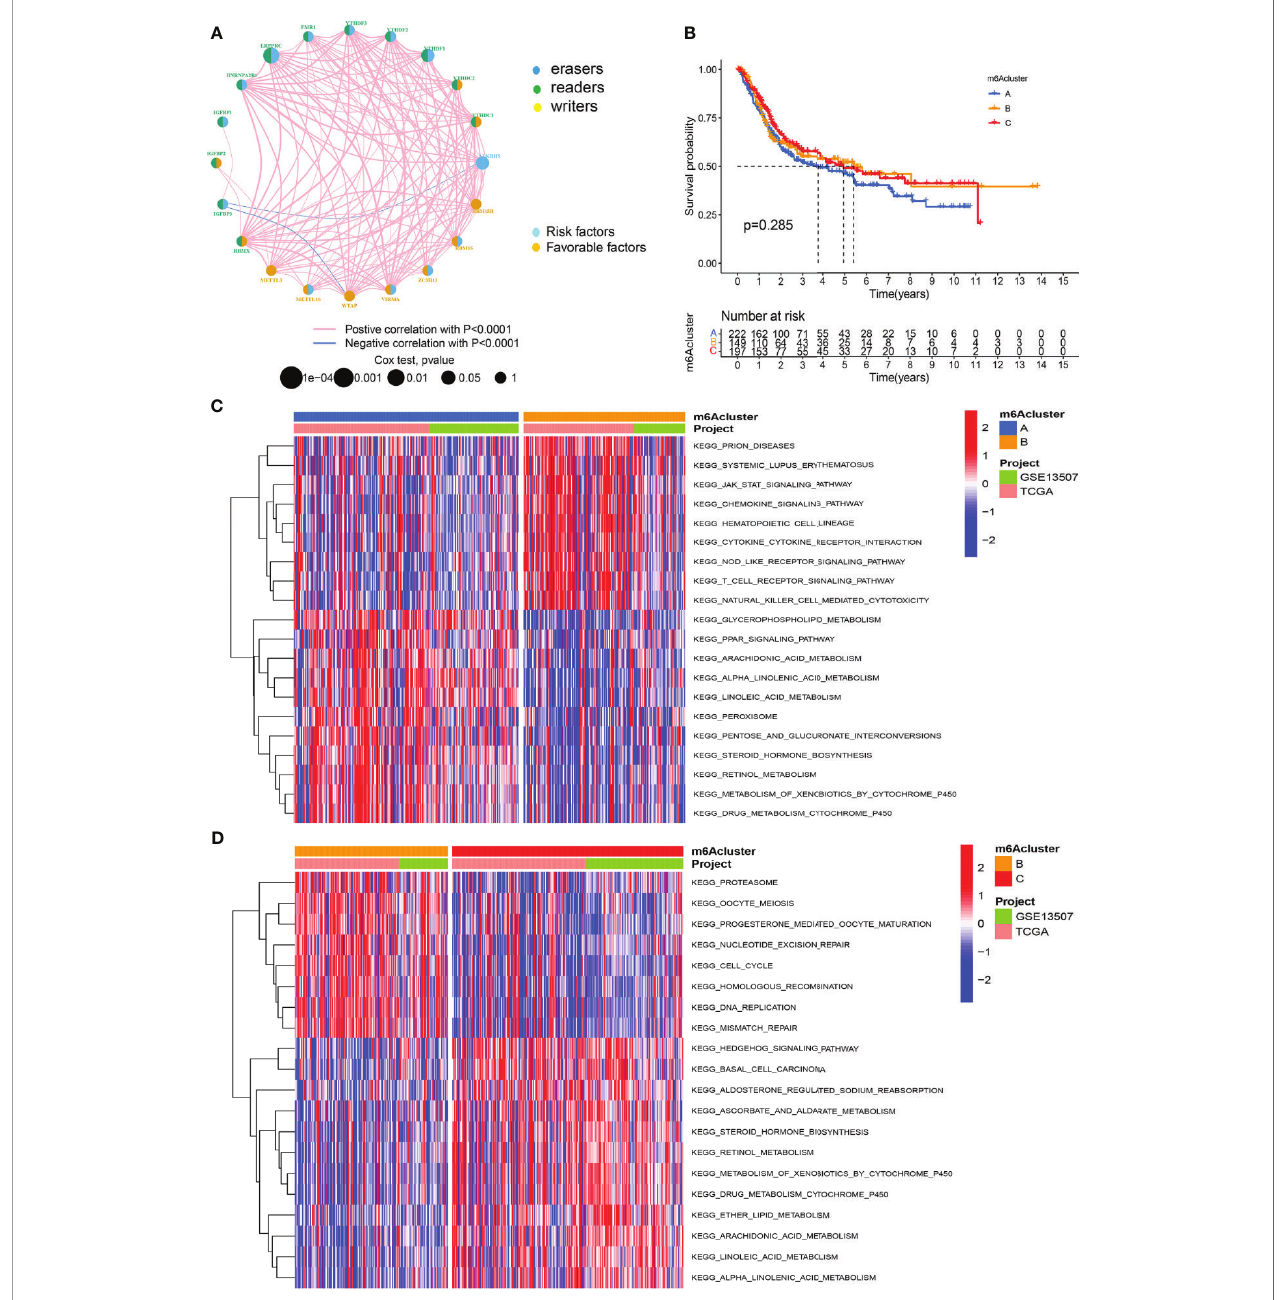
FIGURE 2 | M6A methylation modi fi cation patterns and the biological characteristics of each pattern. (A) M6A regulates the prognosis network diagram. (B) Survival analysis for m6A modi fi cation patterns. (C) GSVA analyzed the differences between functional pathways in m6A modi fi cation patterns. Blue represents the m6A modi fi cation pattern A, and orange represents the m6A modi fi cation pattern B. (D) GSVA analyzed the differences between functional pathways in m6A modi fi cation patterns. Orange represents the m6A modi fi cation pattern B, and red represents the m6A modi fi cation pattern